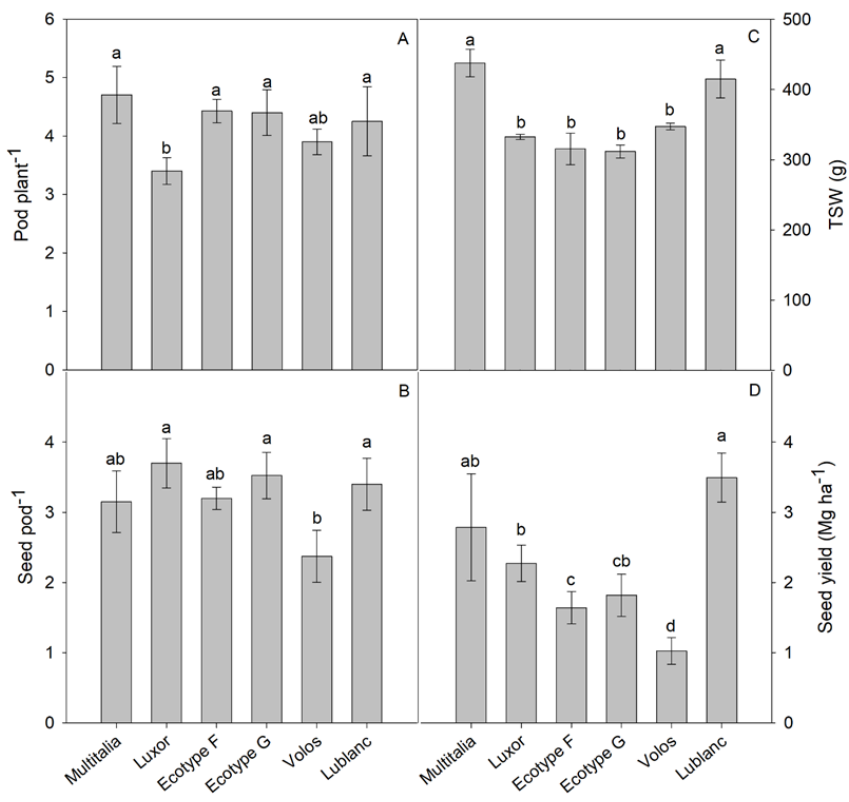
Figure 4. Number of pods per plant ( A ), number of seeds per pod ( B ), thousand-seed weight ( C ), and seed yield ( D ) of six white lupin ( Lupinus albus L.) genotypes. Mean values ± standard deviation with different letters differ significantly ( p ≤ 0.05).